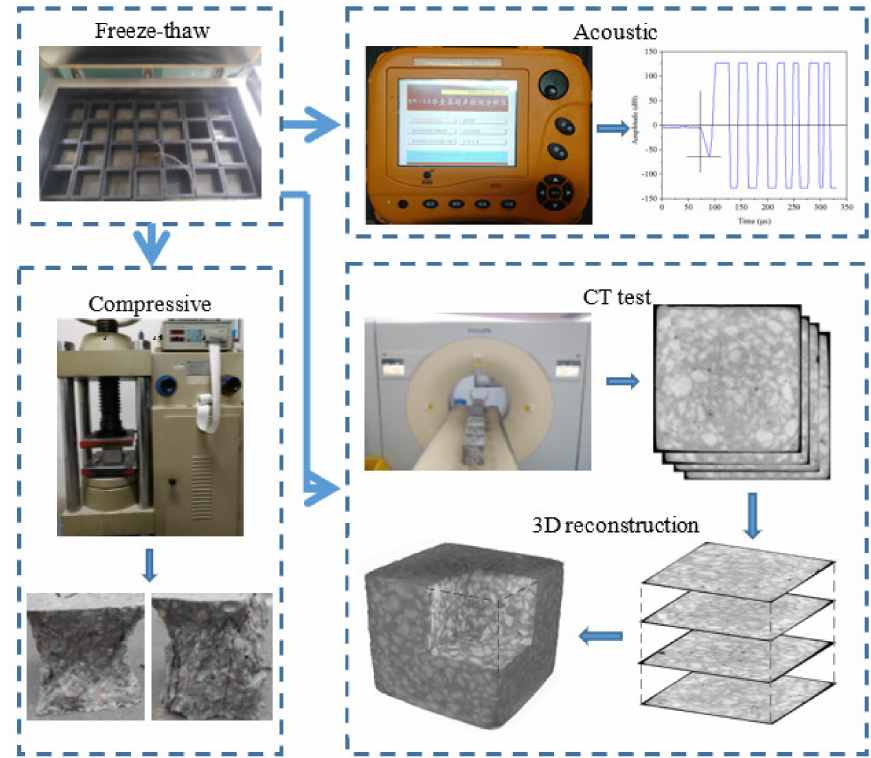
Figure 1. Major test and analysis process.